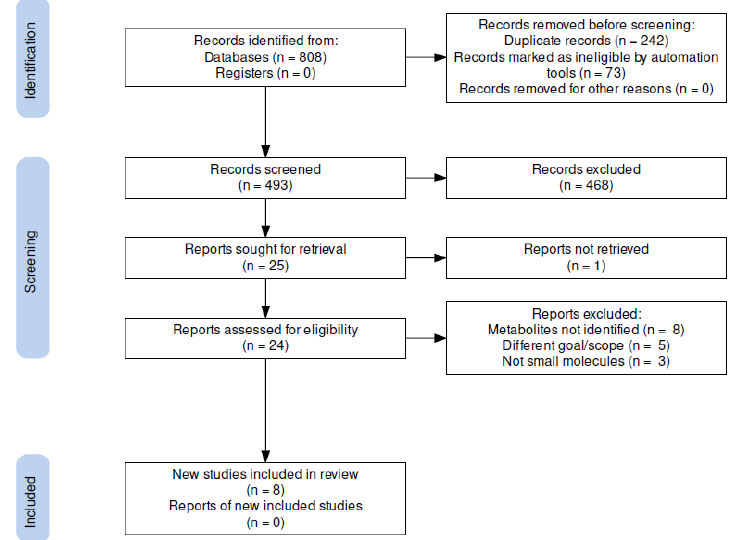
Figure 1. PRISMA flowchart. Flowchart of systematic literature search according to PRISMA-S guidelines. Modified from Page et al. [47]. The flow diagram was constructed using the PRISMA2020 online tool [48]. Detailed information on the literature search is presented in the PRISMA-S checklist in Table S1.